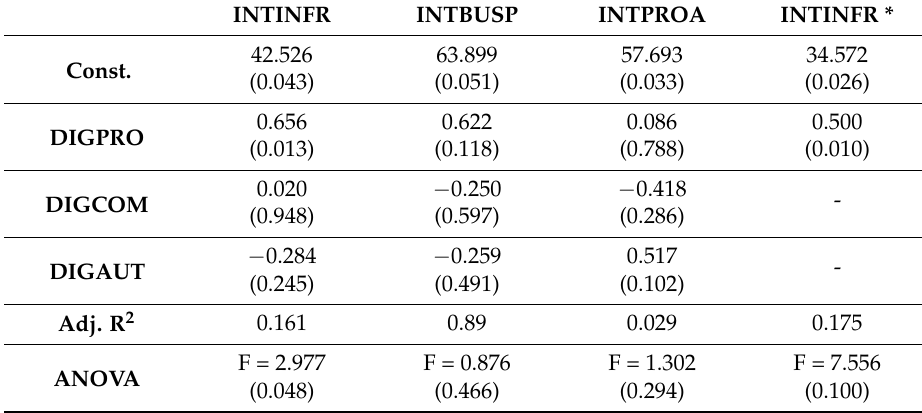
Table A2. Analysis for factors of 4PL Providers constructs.